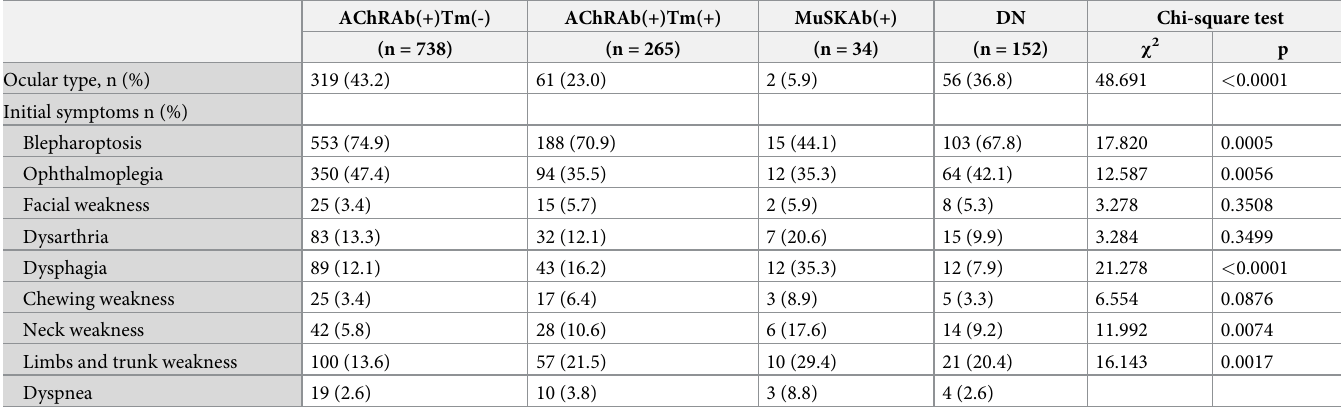
Table 4. Initial symptoms of patients.